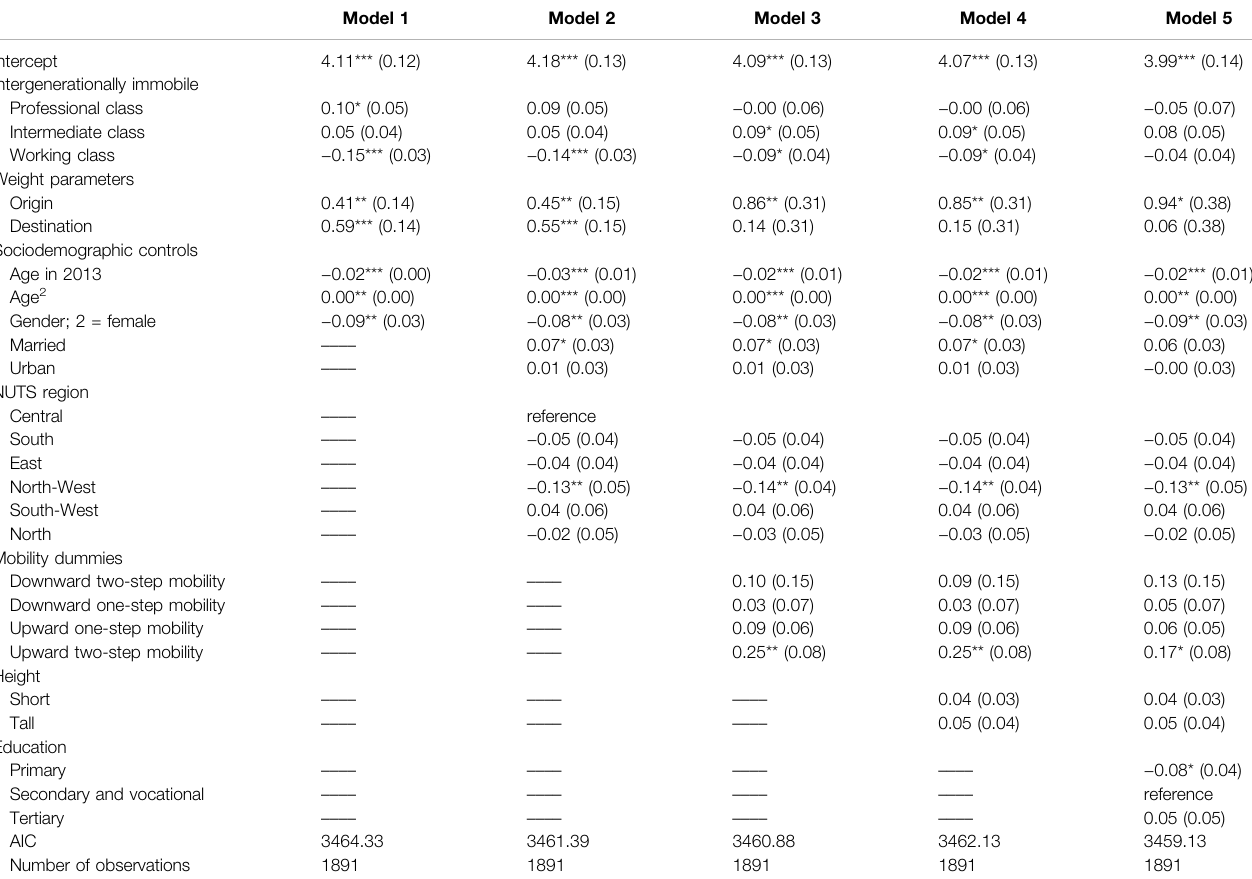
TABLE 3 | Base and full models for reported psychological